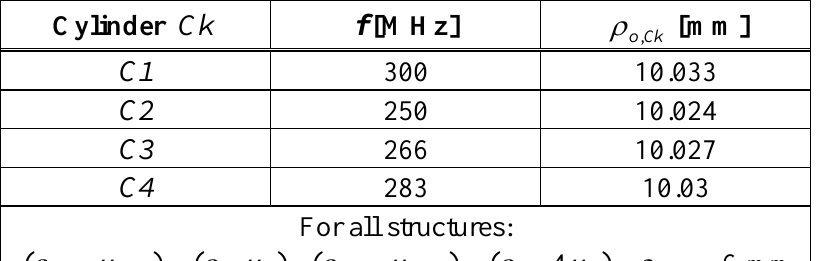
Table 1. Electrical and geometrical parameters of dipolar 1-cylinder